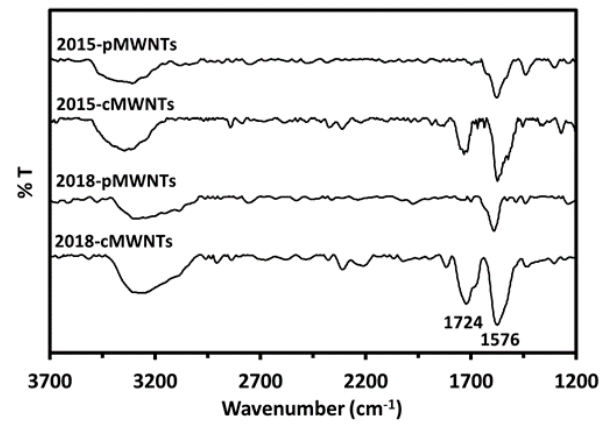
Figure 5. Normalized FTIR spectra of the four MWNT powders; from top to bottom: 2015-pMWNTs, 2015-cMWNTs, 2018-pMWNTs, and 2018-cMWNTs.